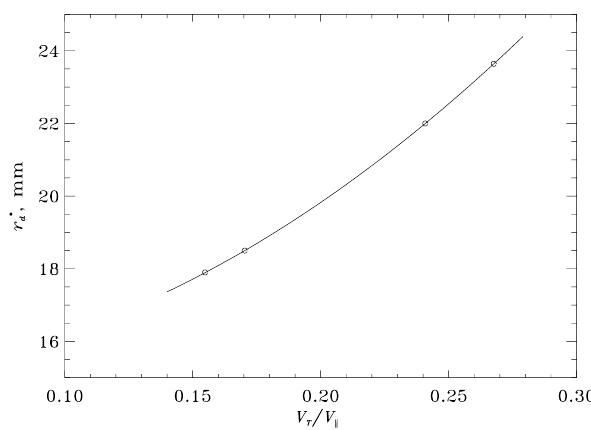
Fig. 6. Effective size of the entrance diaphragm as a function of the ratio between thermal and bulk